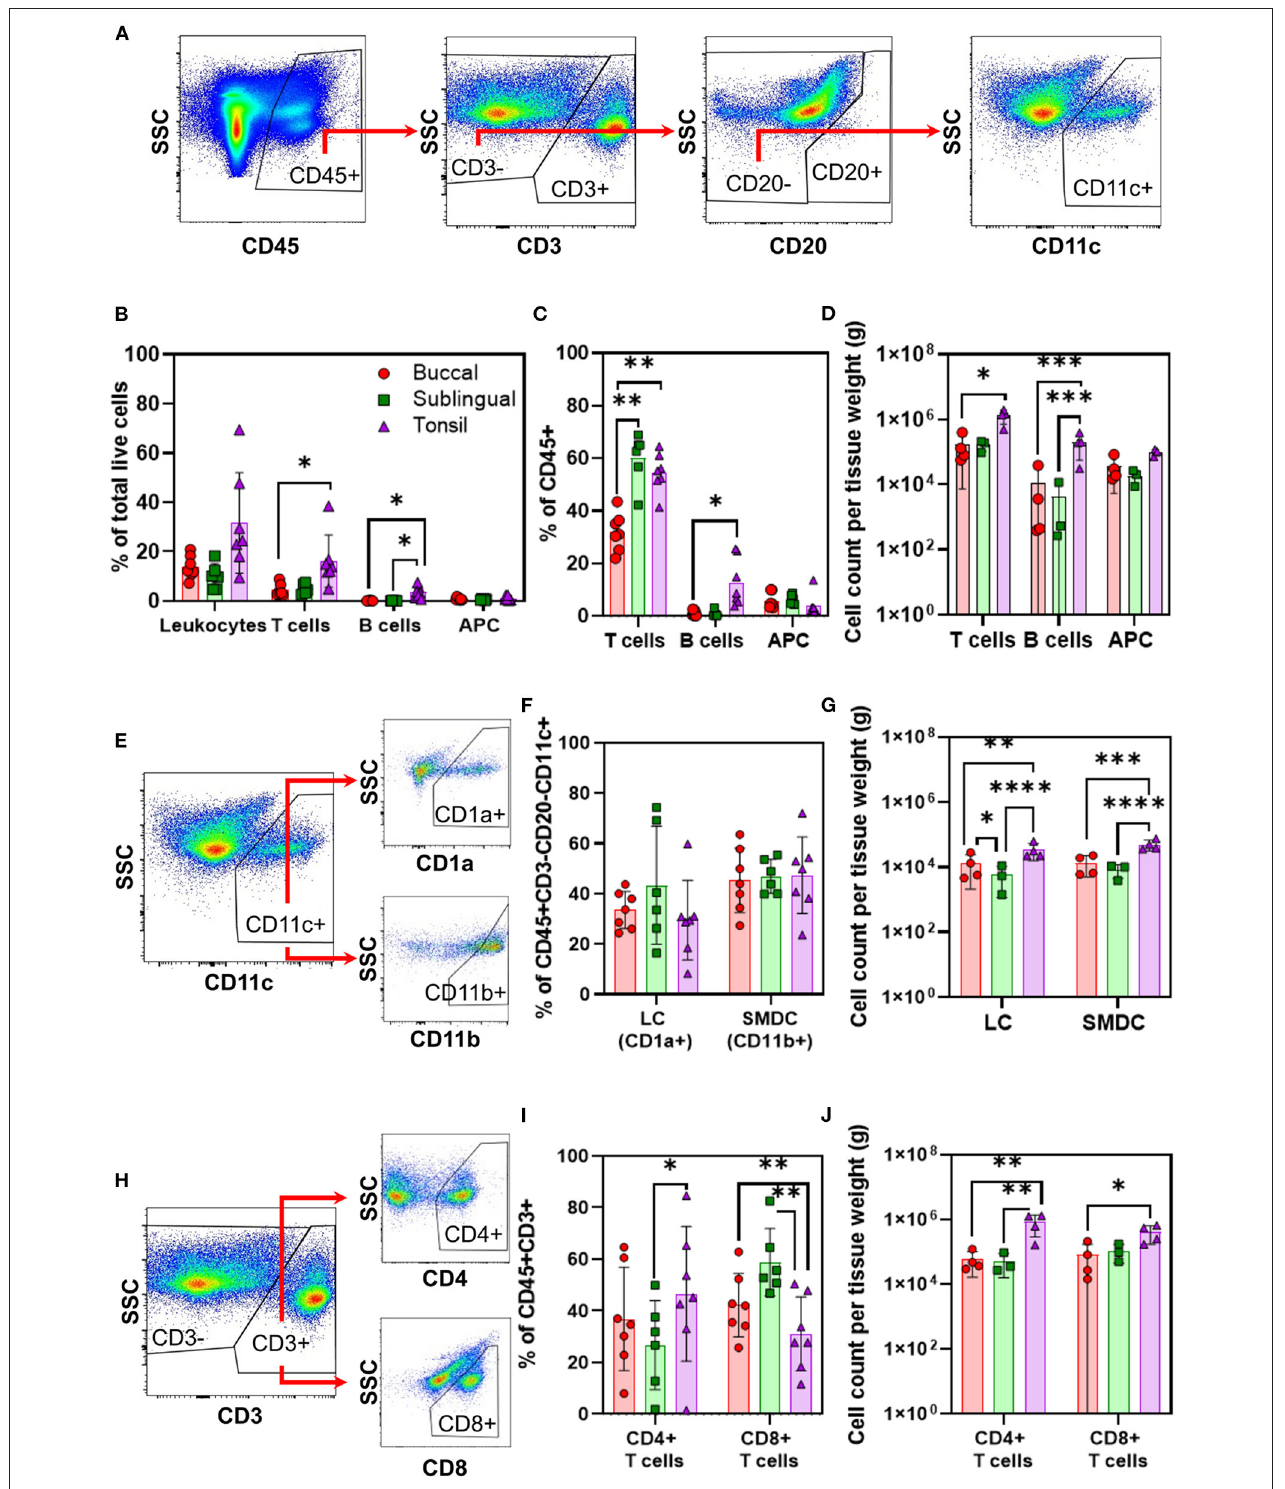
FIGURE 1 | Biopsy samples from oral cavity sites show significantly different frequencies in lymphocytes but not APC populations. APCs and T-cells are present in greater frequencies per tonsil mass. Flow cytometry analysis on immune cell identification is shown for biopsy samples of buccal (red, •), sublingual (green, (cid:4) ), and tonsil tissues (purple, N ). (A) Representative gating strategy is shown by serial gating procedure for APCs (CD45 + , CD3–, CD20–, and CD11c + cells). (B) Cell